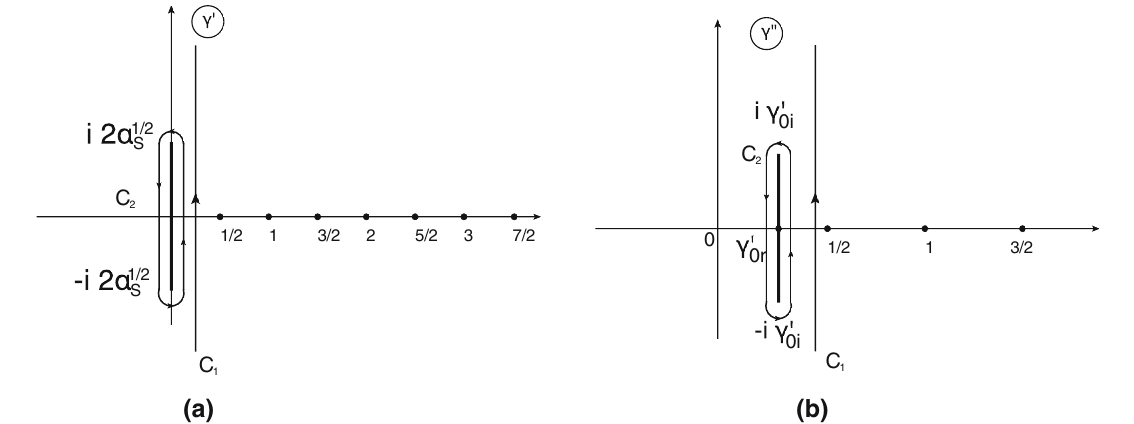
Fig. 1 The γ -plane: the contours of integrations over γ (cid:4) in Eq. (21) and in Eq. (36) ( a ); and the contours of integrations in general case ( b ) Fig. 2 Solution ˜ N ( Y ,ξ) of Eq. (40) versus ξ (solid lines). The dotted lines are the fit ˜ N ∝ exp ( − μ 2 b 2 ) with μ 2 = 0 . 07 /( r R ) for a , b and μ 2 = 0 . 007 /( r R ) for c , d . In all estimates ¯ α S = 0 .